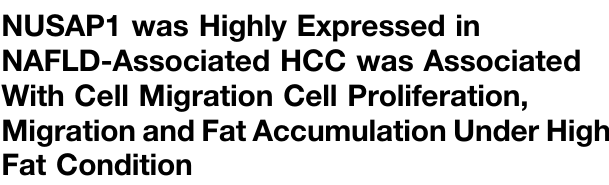
Frontiers in Pharmacology |